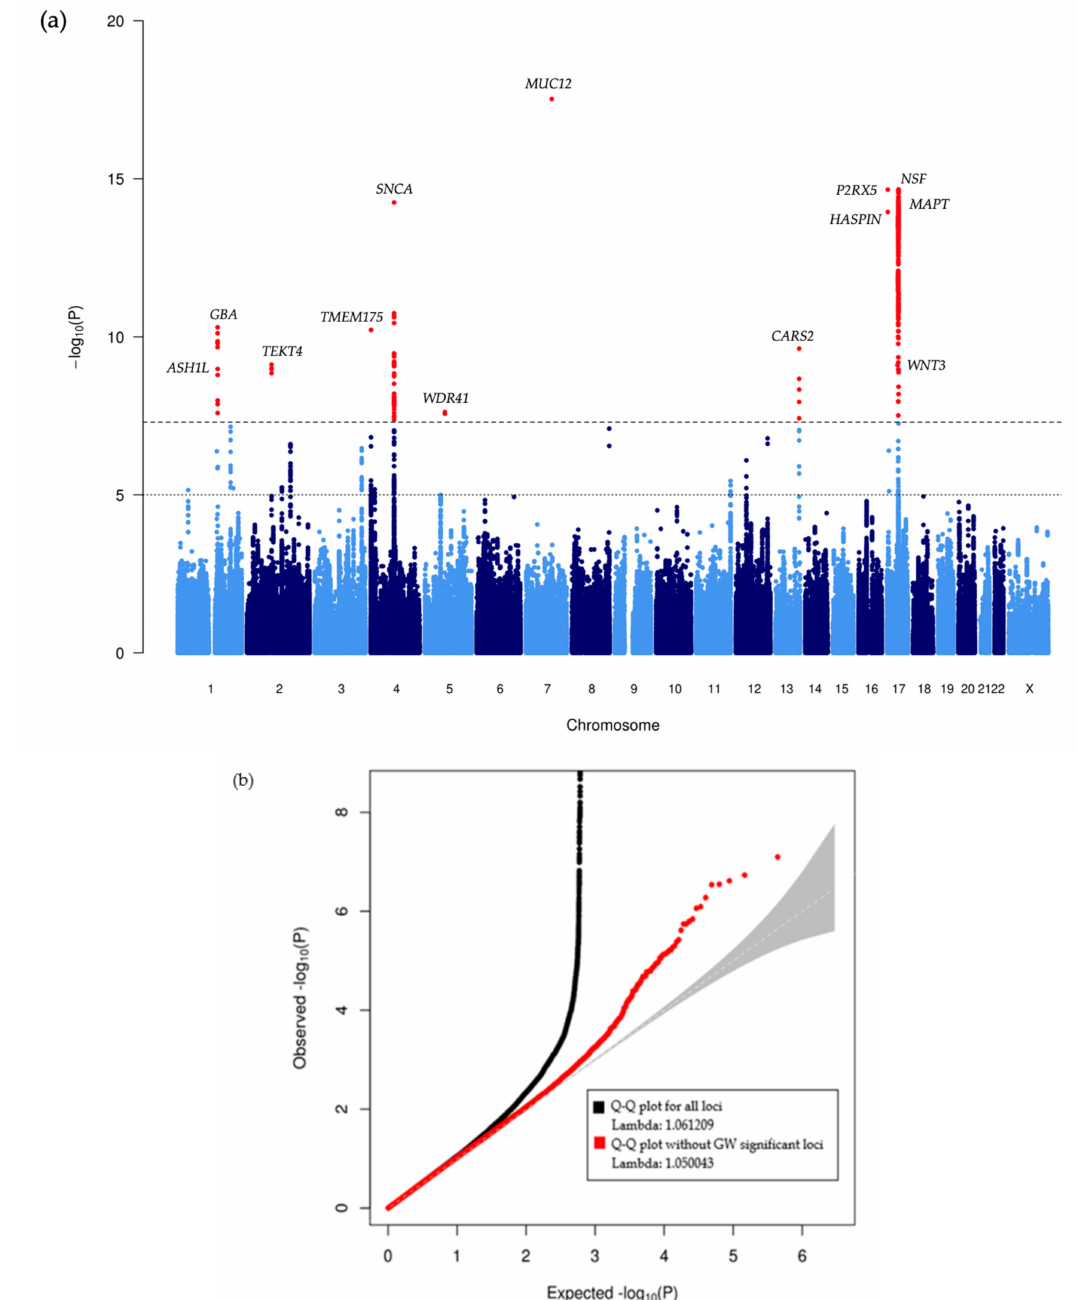
Figure 1. ( a ) Manhattan and ( b ) Q–Q plot of the genome-wide association analysis. The Manhattan plot, representing the − log 10 p -values against the chromosome position. All genome-wide (GW) significant SNPs are depicted in red and the nearest gene of the most significant variant in each locus is labelled. The Q–Q plot shows the expected − log 10 p -values under the null hypothesis on the x axis, while observed − log10 p -values are represented on the y axis. The λ is a measure of the genomic inflation (observed median χ 2 test statistic/median expected χ 2 test statistic under the null